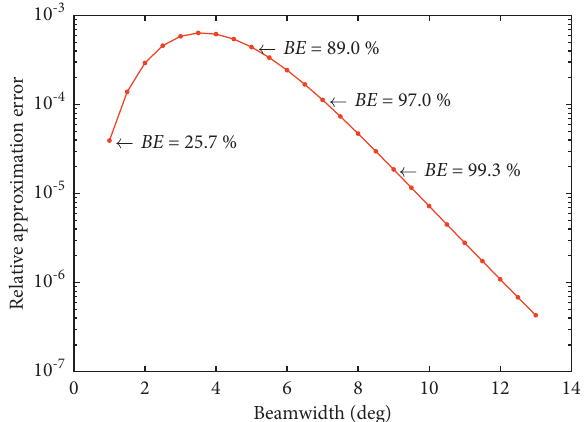
Figure 9: Relative approximation error of beam efciency in pencil beam arrays with 30 elements, obtained by minimization of SLP. Selected values of obtained beam efciencies, BE s, are added to graph. Figure 10: Beam efciency of pencil beam arrays with various